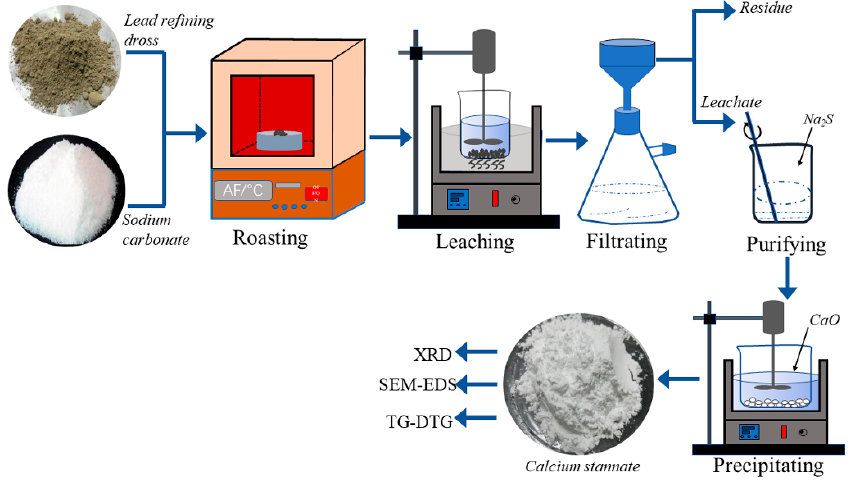
Figure 2. Flowsheet of the experimental process.